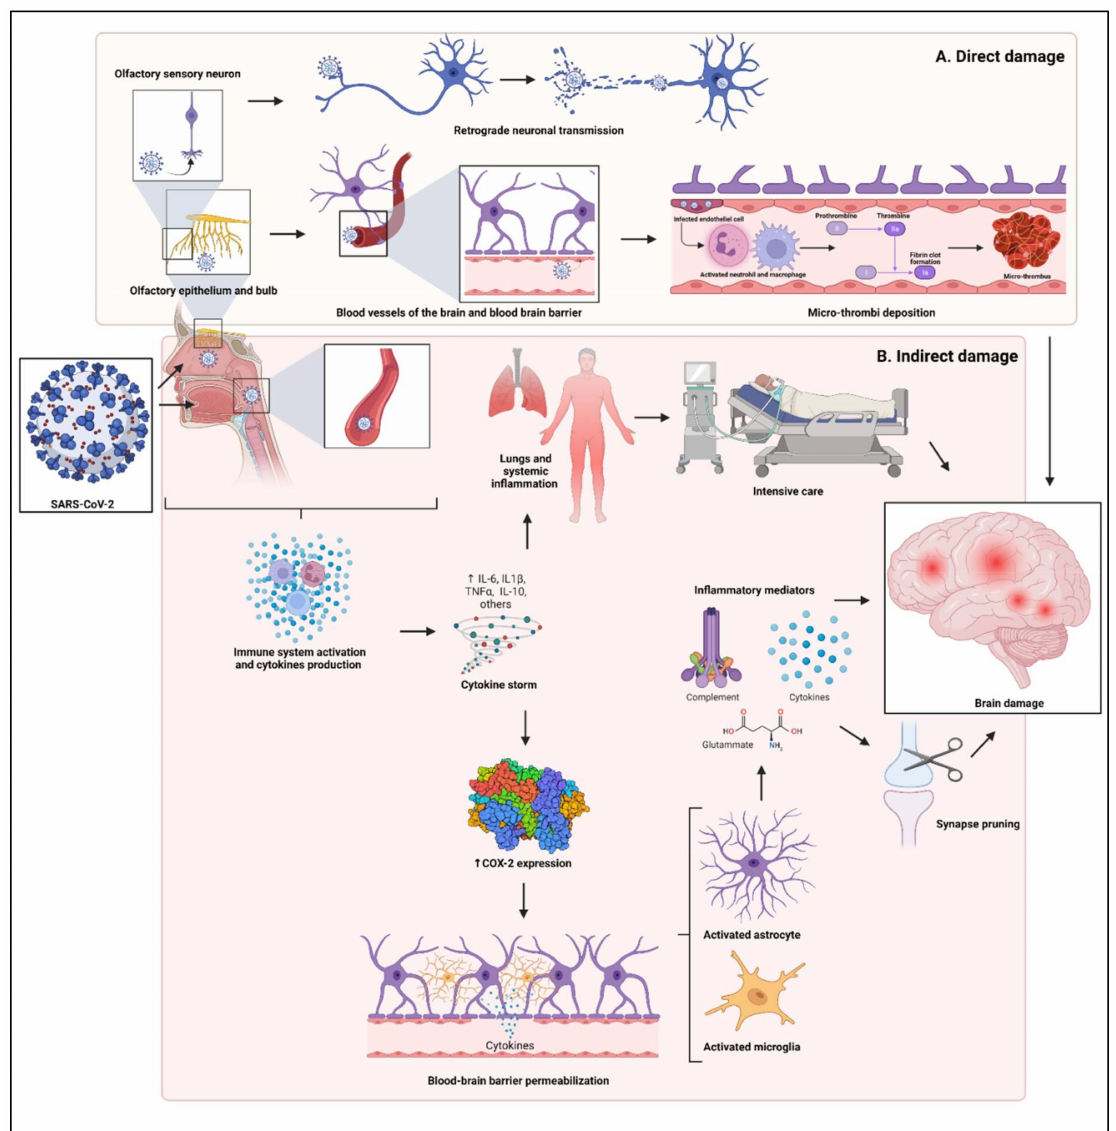
Figure 1. Possible mechanisms of direct and indirect SARS-CoV-2 infection damage to the brain. ( A ) Direct damage: SARS-CoV-2 infects the olfactory nerve and then the olfactory bulb. Via retrograde neuronal transmission, it reaches other CNS regions [44–46] (upper part of panel ( A )). It infects endothelial cells of the brain vascular system and activate neutrophils, macrophages, thrombin production, and complement pathways, promoting micro-thrombi deposition [48] (lower part of panel ( A ). ( B ) Indirect damage: SARS-CoV-2 spreads to the whole organism and causes a massive activation of the immune system. This results in a cytokines storm and in a marked systemic inflammatory response [53,54]. An overactive immune response can cause lungs damage and the need for intensive care. Aggressive life-saving treatments in intensive-care units may contribute to the brain damage [11] (upper part of panel ( B )). Cytokines induces expression of cyclooxygenase 2 (COX-2). The activity of COX-2 increases blood-brain barrier permeability. This facilitates the entry of cytokines within the CNS, which causes the activation of astrocytes and microglia [55–57]. These activated cells produce mediators of neuro-inflammation (e.g., glutamate, complement proteins, and interleukins), that induce structural changes, in particular, the pruning of the synapses [57,58] (lower part of panel ( B ). Both direct and indirect brain damages can converge in a neuronal loss that might represent the biological underpinning of the neuro-psychiatric symptoms described in SARS-CoV- 2 infection [11,52] (not shown). SARS: severe acute respiratory syndrome; CoV: coronavirus; IL: interleukin; and TNF: tumor necrosis factor. Created with